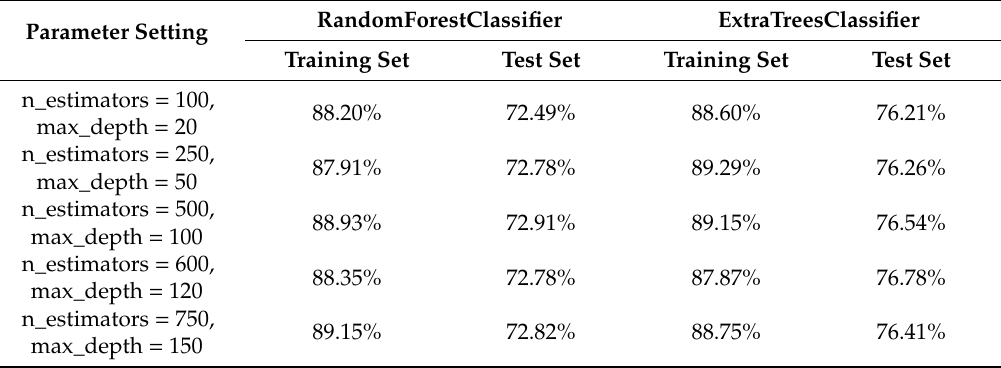
Table 9. Accuracy of RandomForestClassifier and ExtraTreesClassifier with di ff erent